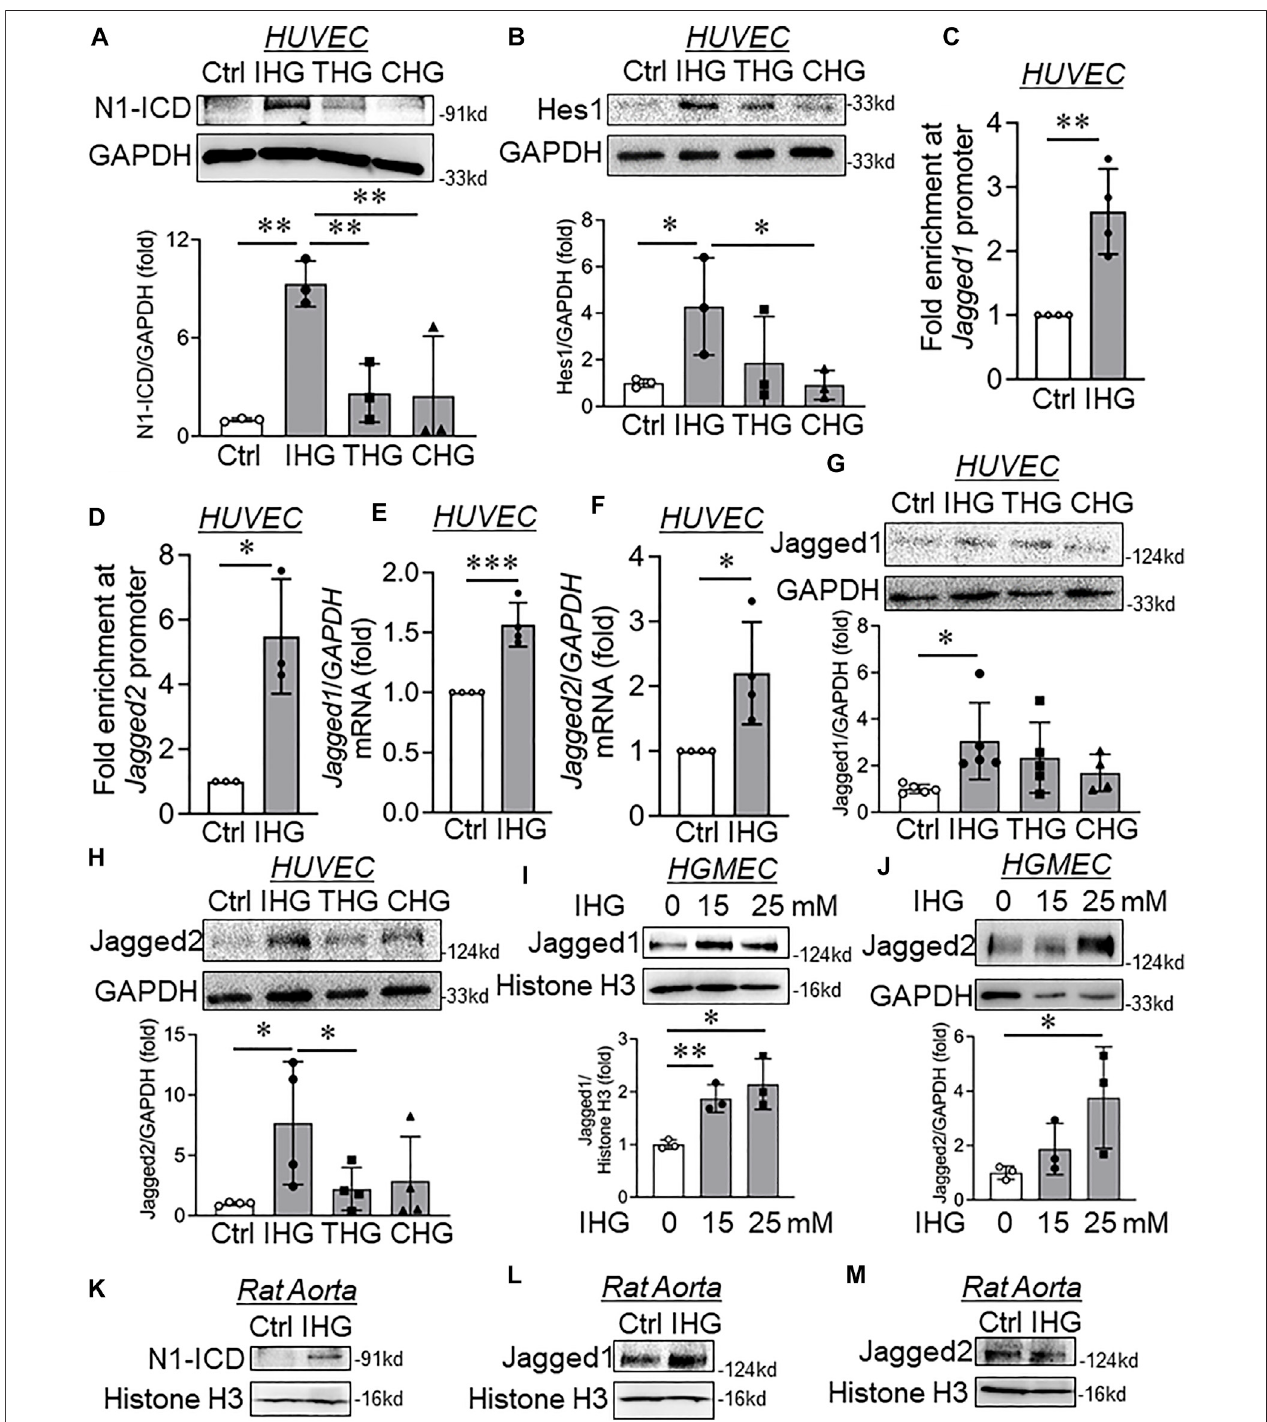
FIGURE3| ElevatedH3K4me3uponintermittenthigh-glucoseexposureenrichedinJagged1andJagged2promoter,therebycausingtheirexpressionandNotch activation in endothelialcells. (A , B) Immunoblot analysisof endothelial cell lysates collected from cells treated with intermittent, transient, and constant high glucose and probed for N1-ICD ( A , n = 3) and Hes1 ( B , n = 3). (C , D) ChIP-qPCR analysis of H3K4me3 enrichment on Jagged1 ( C , n = 4) and Jagged2 ( D , n = 3) gene promoters in HUVEC exposed to intermittent hyperglycemia. (E , F) Transcript-level expression of Jagged1 ( E , n = 4) and Jagged2 ( F , n = 4) measured through RT-qPCR technique in HUVEC challenged with an intermittent high-glucose condition. (G , H) Immunoblot analysis of HUVEC lysates collected from cells treated with differential high-glucose treatment conditions and probed for Jagged1 ( G , n = 5) and Jagged2 ( H , n = 4). (I , J) Human glomerular endothelial cells (HGMEC) were treated with